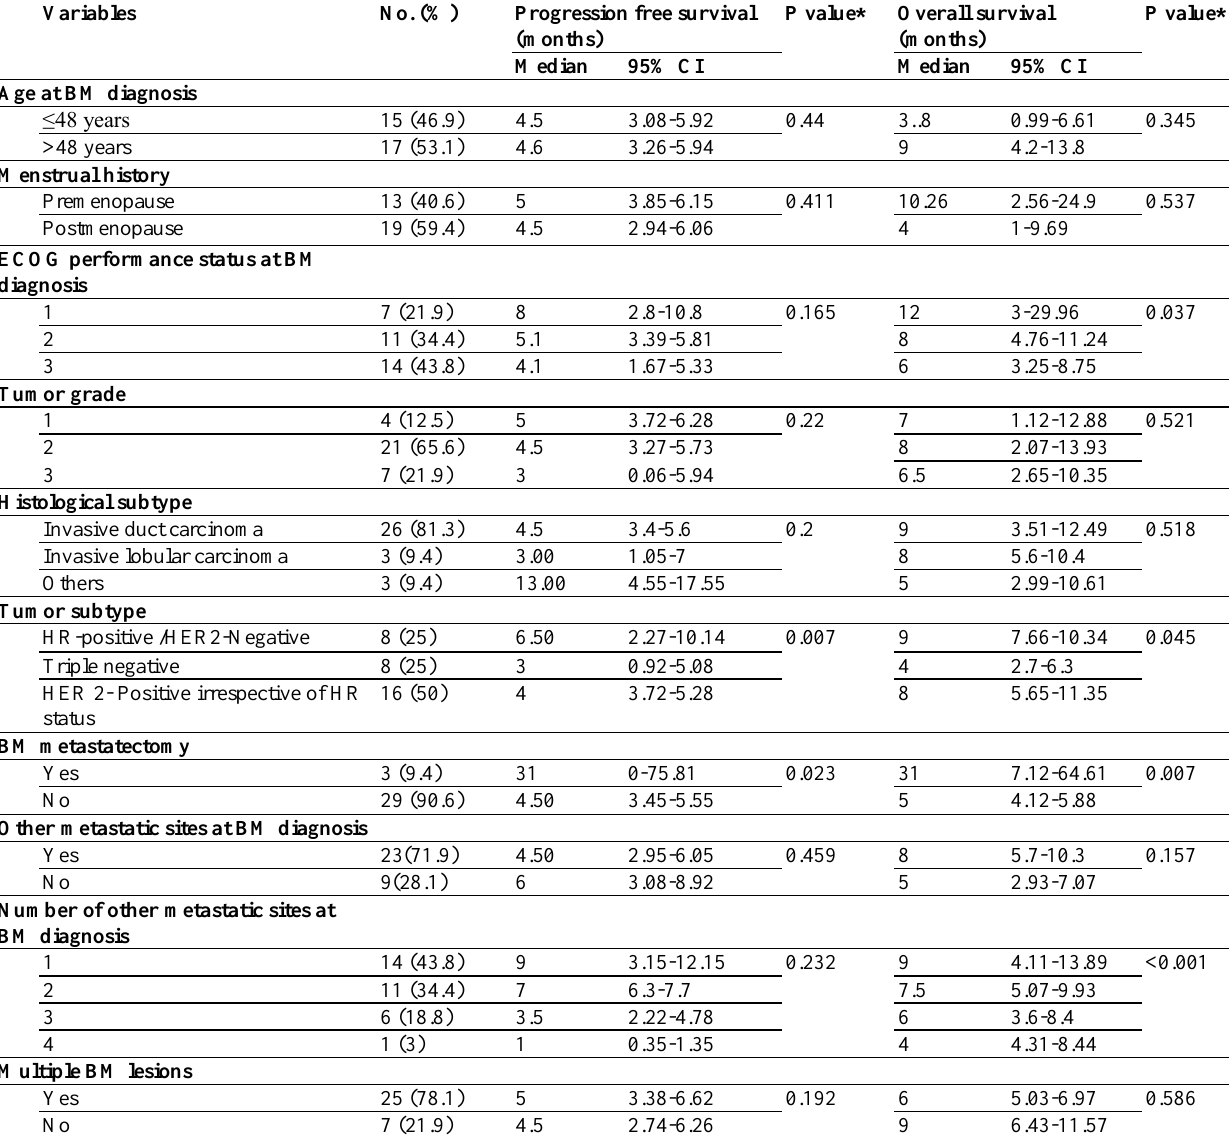
Table 3. Univariate analysis of progression free survival and overall survival of 32 breast cancer patients with brain